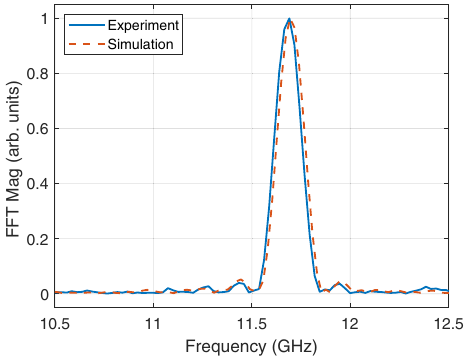
FIG. 17. Experimental rf pulse generated by a single 7 nC bunch, along with accompanying PIC simulation results.